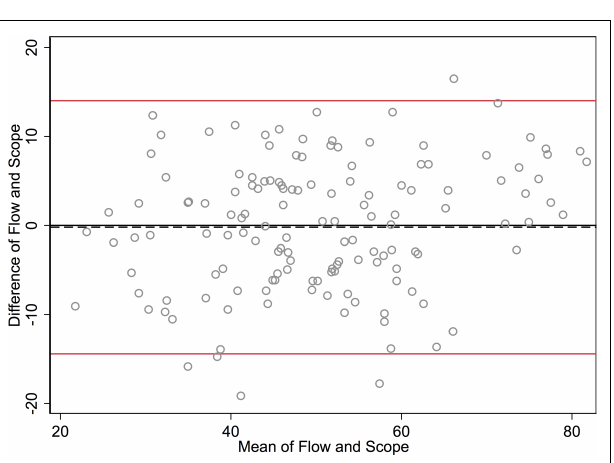
FIGURE 3 | Bland-Altman plot graphs the difference of the two methods’ measurements against their means. The 95% limits of agreement (LOA) are shown (red lines) at − 14.422 and 14.024. The line of perfect agreement at 0 is also shown (solid black line) along with the average of the observed differences (=average bias) at − 0.199 (dashed black line).